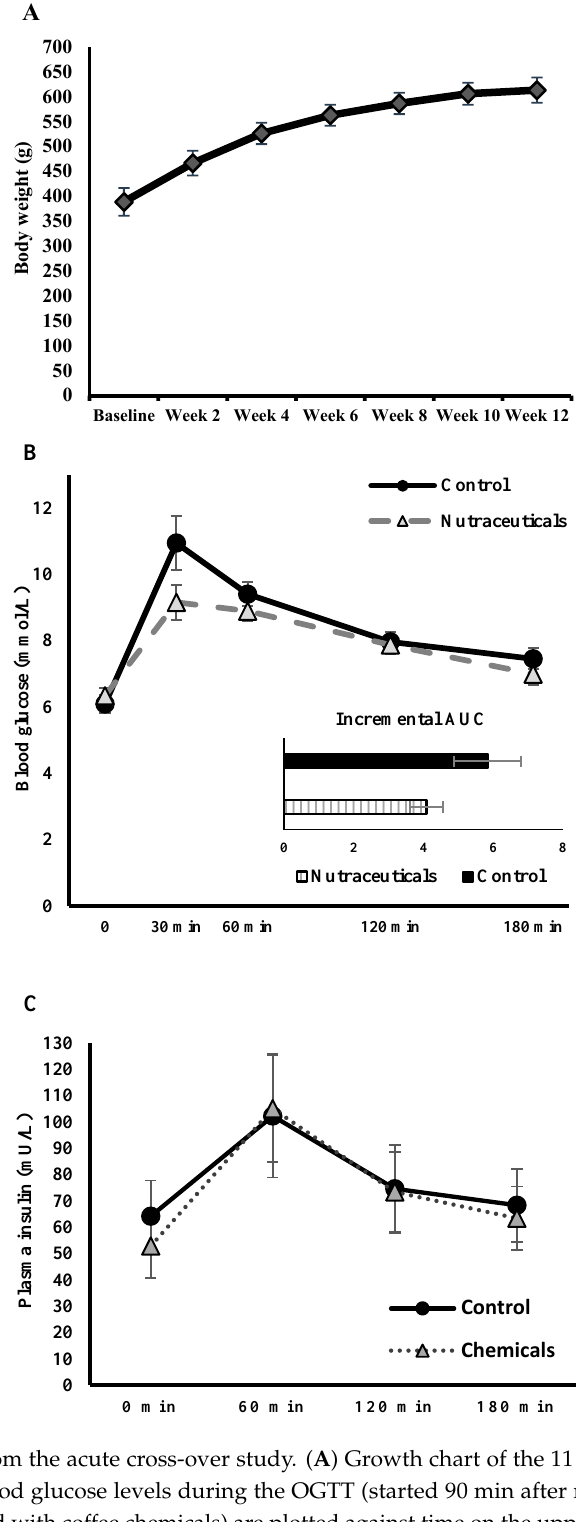
pellets supplemented with coffee chemicals) are plotted against time on the upper part. Under the line